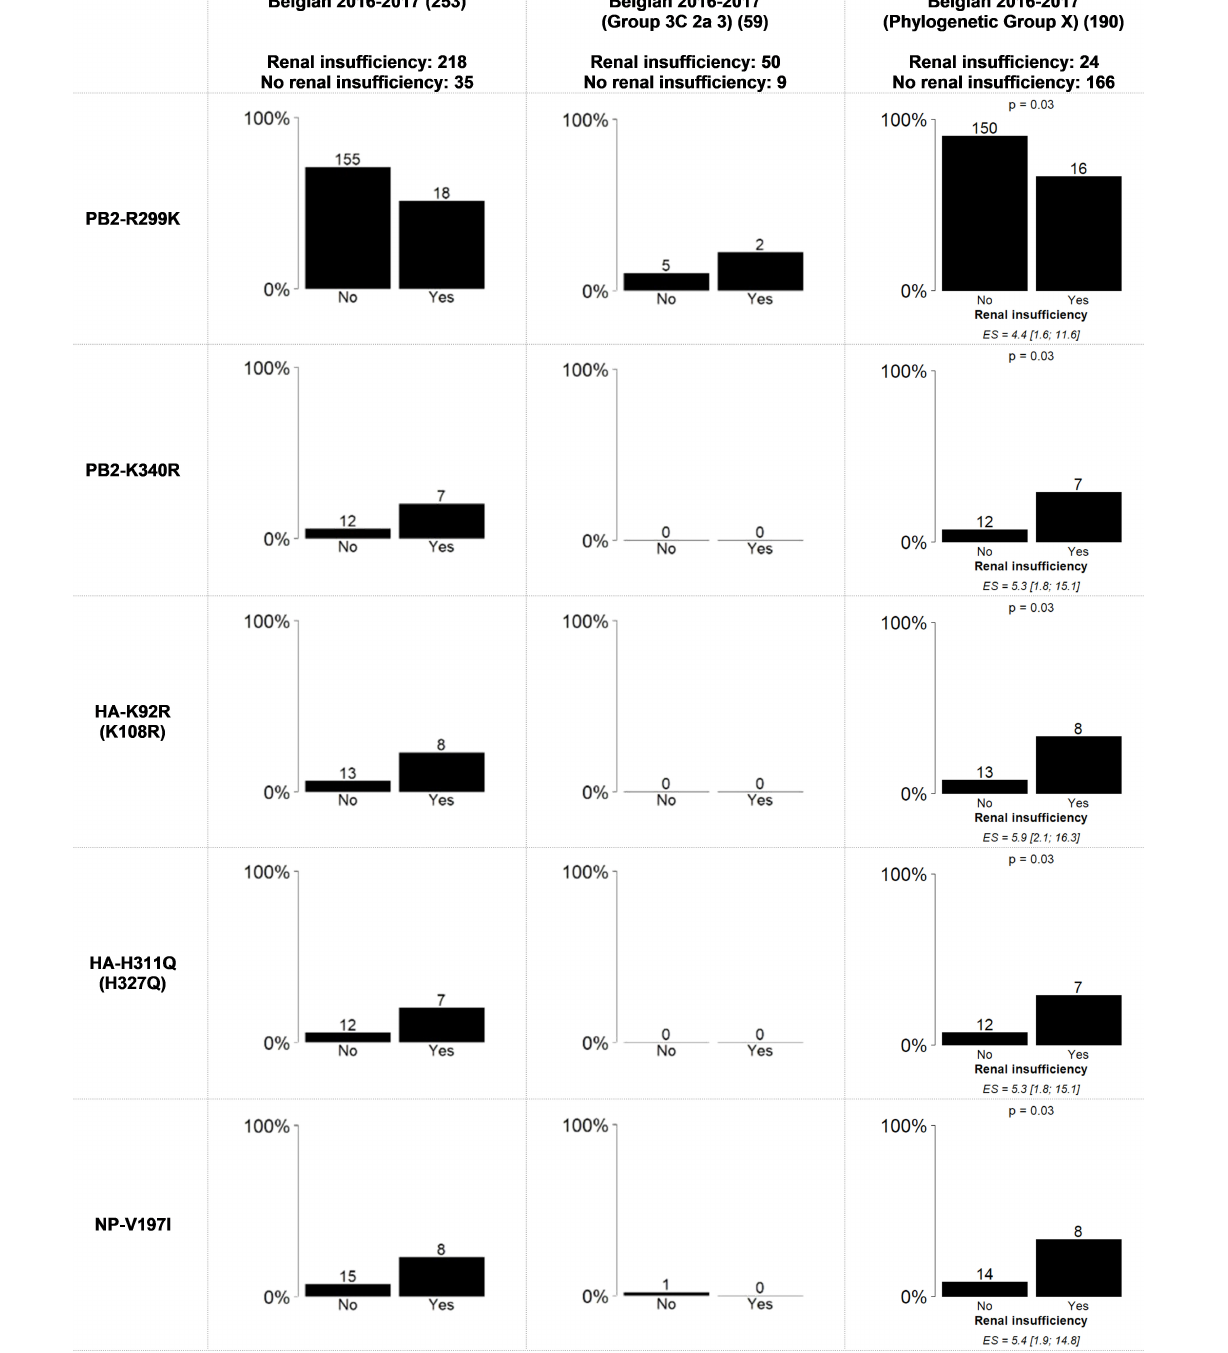
Frontiers in Microbiology |